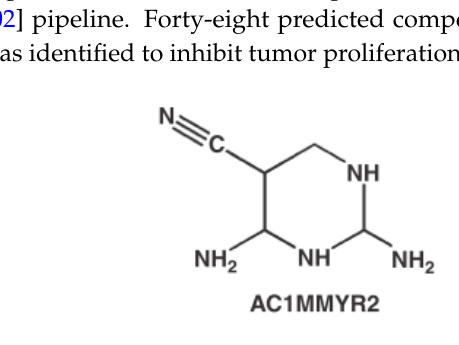
Figure 25. Chemical structure of AC1MMYR2.